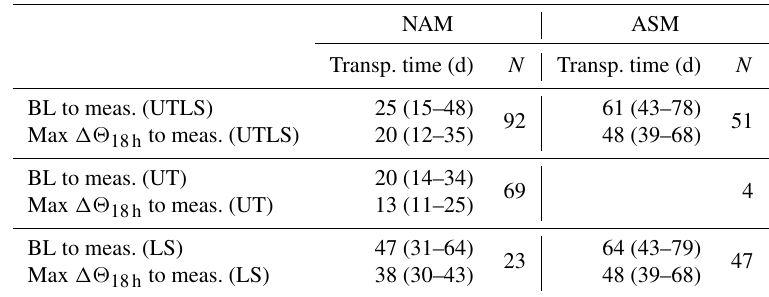
Figure 7. Location of maximum change in potential temperature over a time interval of 18h (max (cid:49)(cid:50) 18h ) along back trajectories, color coded with the transport time from the location of measurement to the location of max (cid:49)(cid:50) 18h . (a) CH 2 Cl 2 -poor air; (b) CH 2 Cl 2 -rich air. Shown are the locations of max (cid:49)(cid:50) 18h for CH 2 Cl 2 -rich and CH 2 Cl 2 -poor air from all WISE flights between 28 September and 21 October. Table 2. Median transport times derived from back trajectories calculated for air parcels of CH 2 Cl 2 -poor air uplifted above Central America (location of max (cid:49)(cid:50) 18h within 0–35 ◦ N and 50–120 ◦ W) labeled as NAM and for air parcels of CH 2 Cl 2 -rich air uplifted above southern and eastern Asia (location of max (cid:49)(cid:50) 18h within 0–40 ◦ N and 60–160 ◦ E) labeled as ASM. The median transport times are calculated from both the model boundary layer (BL) and the location of max (cid:49)(cid:50) 18h to the location of measurement in the UTLS, only for samples above the thermal TP (lower stratosphere, LS) and only for samples below or equal to the thermal TP (upper troposphere, UT). The medians are given with the range of the 25th and the 75th percentile in parentheses. N is the number of trajectories used to calculate the respective median. Note that the number of CH 2 Cl 2 -rich air samples observed in the UT and uplifted above southern and eastern Asia is too small to provide reliable transport